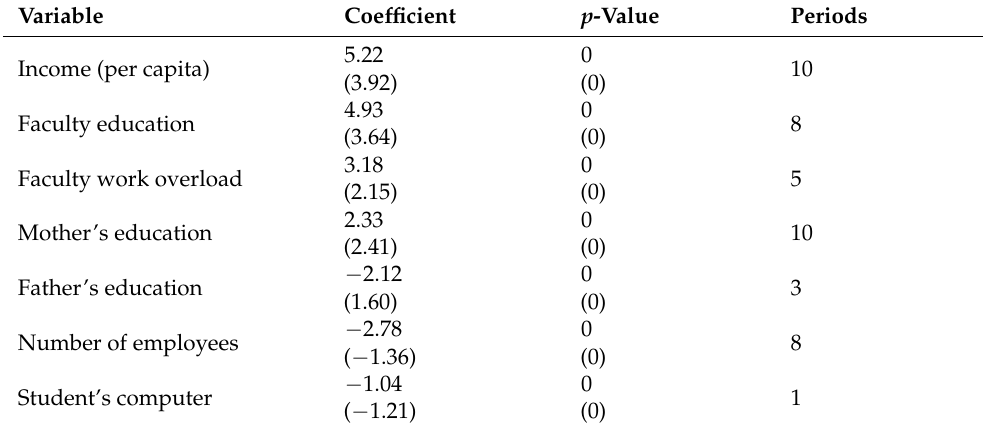
Table 3. Higher coefficients for the logistic regression fixed-effects model to the period of 2012–2019 and the number of times these variables were in the same top 7 ranking in other